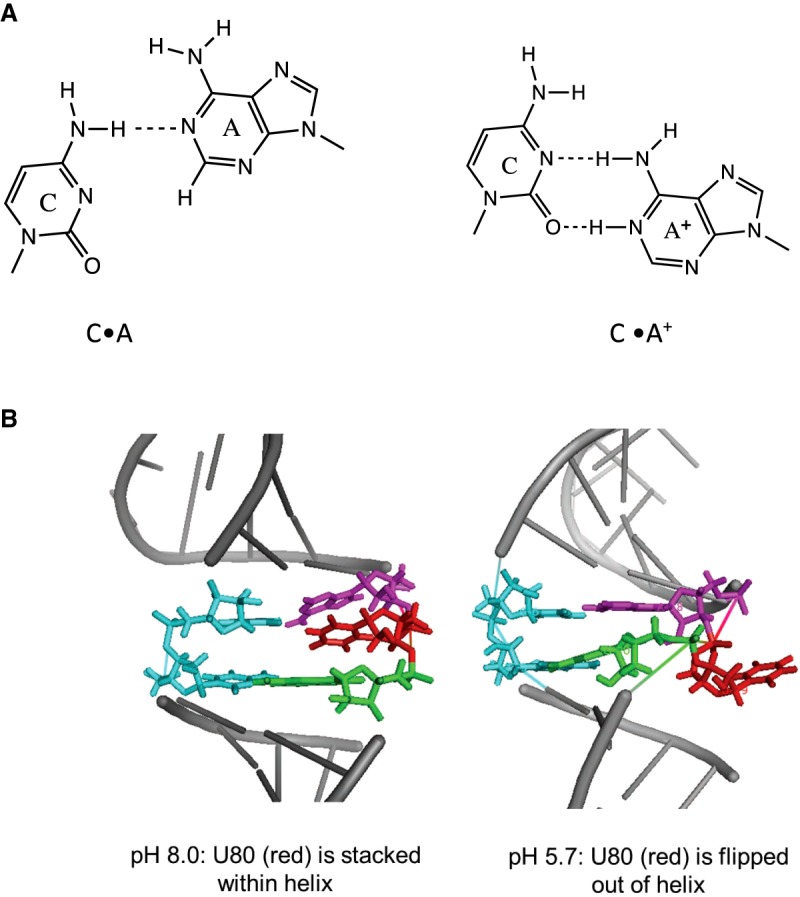
(A) The C•A and C•A+ base pairs. (B) NMR structures of RNA wild-type construct at pH 8.0 (left) and pH 5.7 (right). Image generated using PyMOL, pH 5.7:pdb 1SYZ, pH 8.0: pdb 2KEZ (Reiter et al. 2004; Venditti et al. 2009).